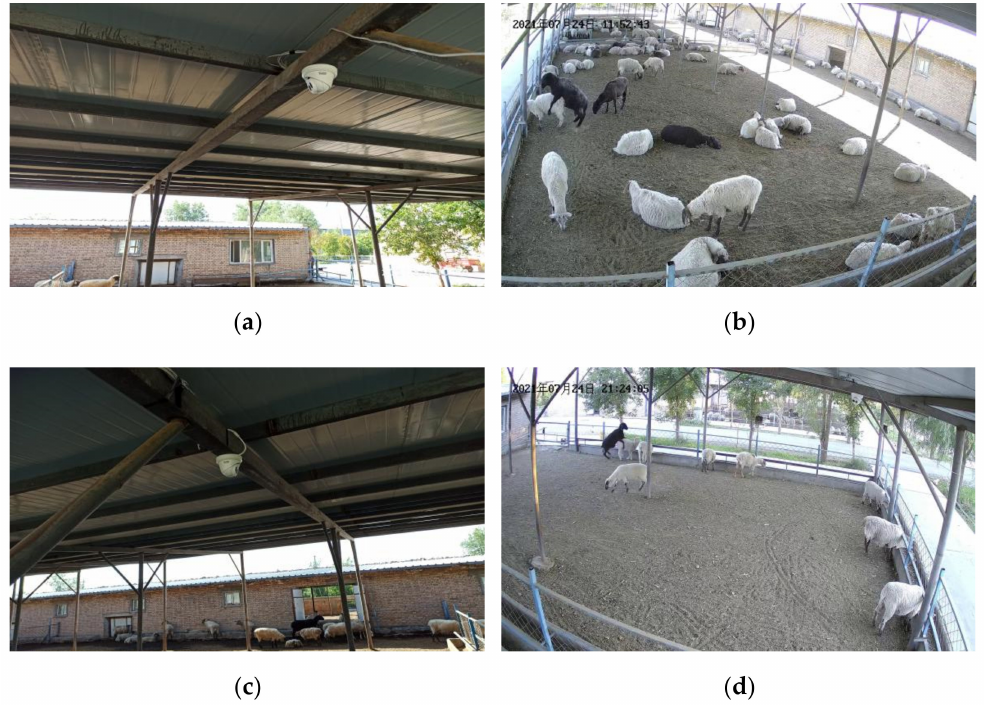
Figure 1. Camera installation position and field of view image: ( a ) Camera 1 installation position; ( b ) Camera 1 view image; ( c ) Camera 2 installation position; ( d ) Camera 2 view image. The Chinese in the upper left corner of the image is the date of the video recording, in order of year, month and